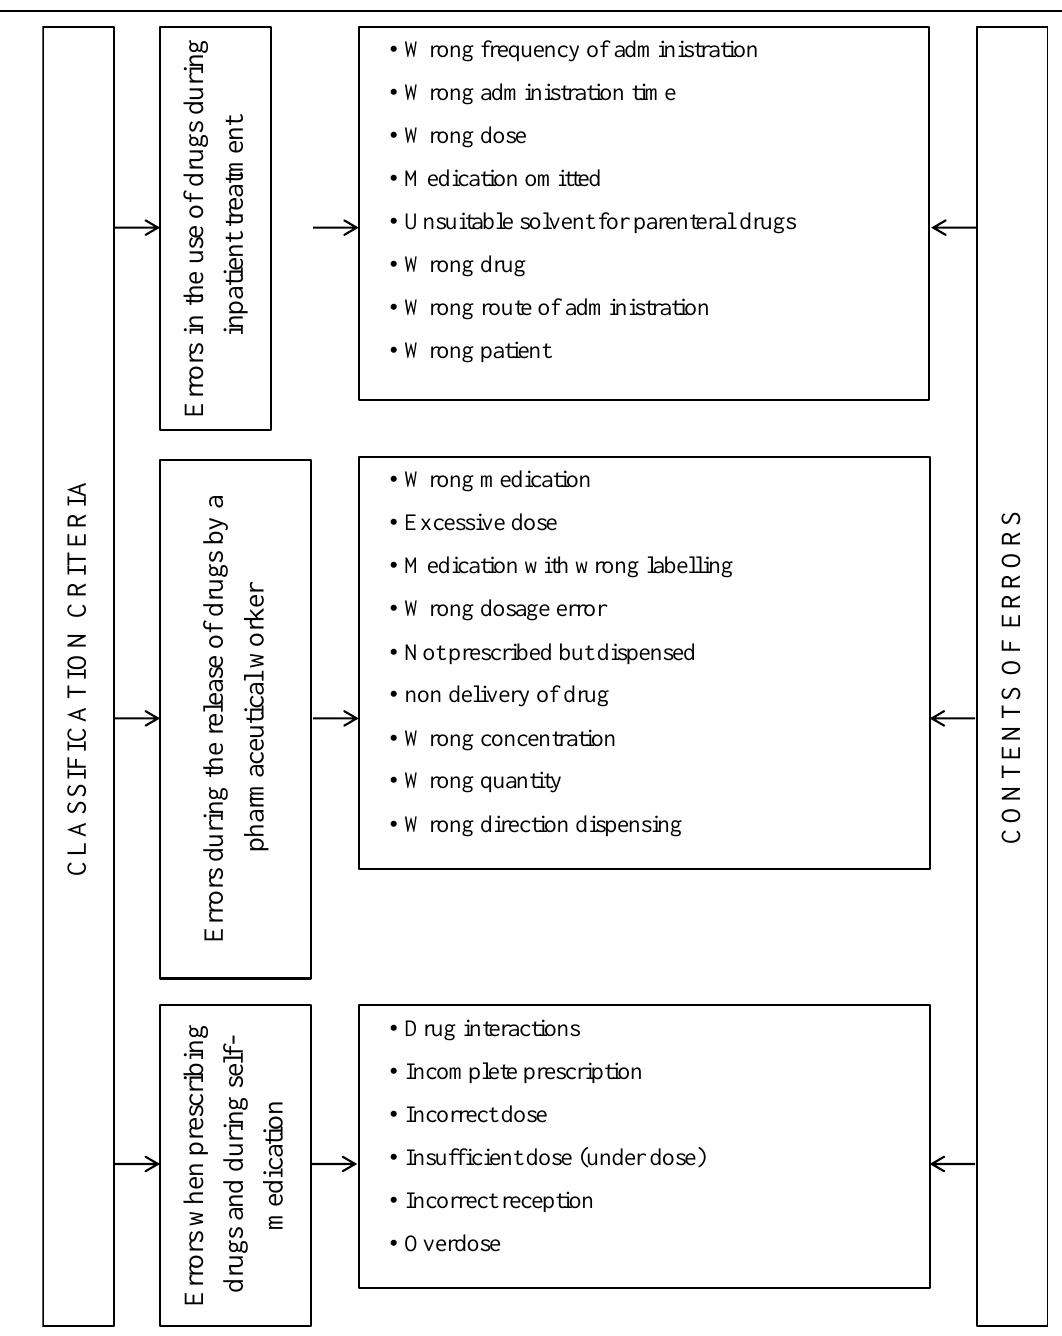
Fig. 1. Generalization of global trends for classification of drug-related errors by